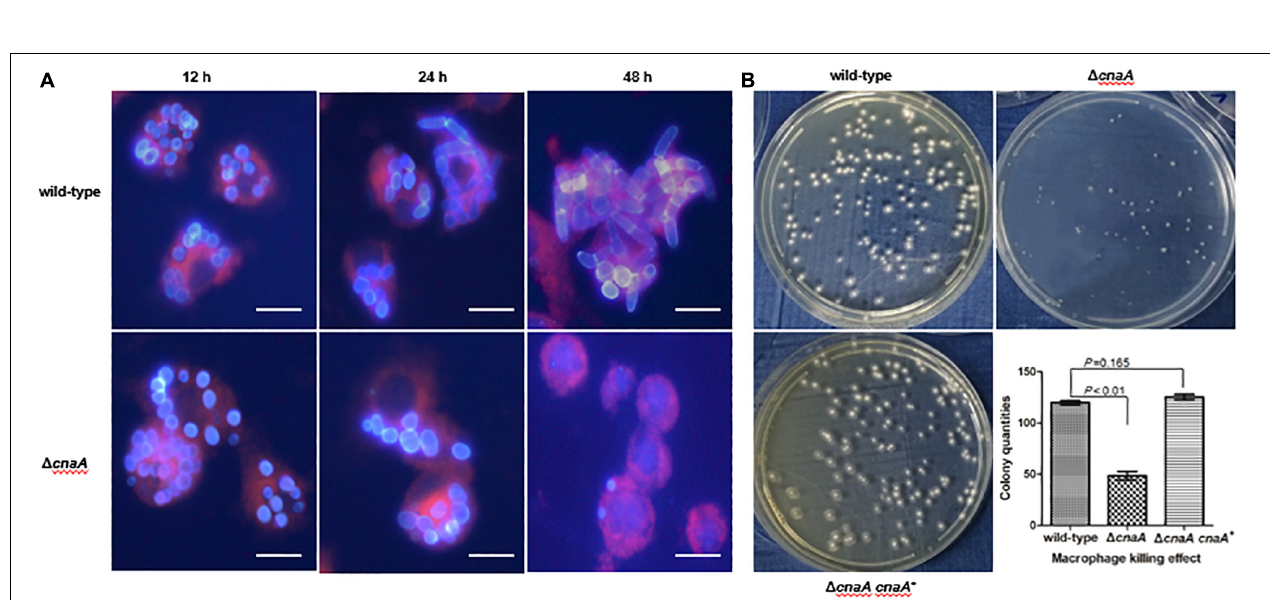
FIGURE 5 | The cnaA gene is required for adaptation to osmotic stress in vitro. To test the stress resistance of mutants, wild-type, and (cid:49) cnaA strains were inoculated with a 5- µ l drop of a 1 × 10 5 conidia/ml suspension onto ANM supplemented as follows: (A) for salt stress using 0.2, 0.4, 0.6, and 1M KCl; (B) for oxidative stress adding 2, 5 and 8 mM H 2 O 2 ; and for osmotic stress adding 0.5, 1, and 1.5 M sorbitol, followed by incubation for 14 days at 25 ◦ C. The (cid:49) cnaA mutant showed a gradual reduction in growth with increasing concentrations of the stress agent, especially for oxidative stress.